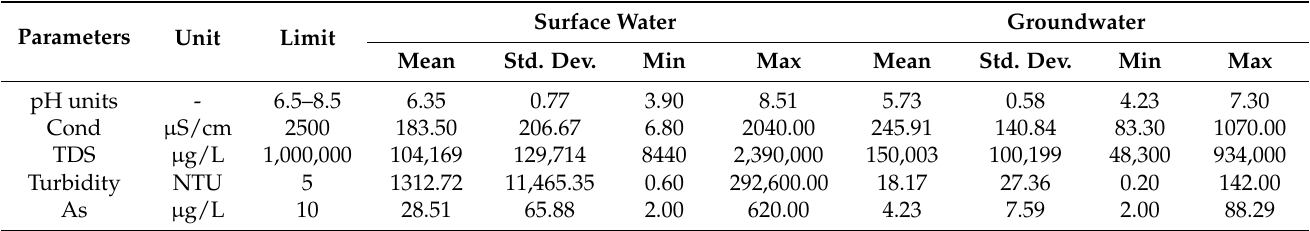
Table 4. Statistical summary of all the measured parameters and WHO guideline